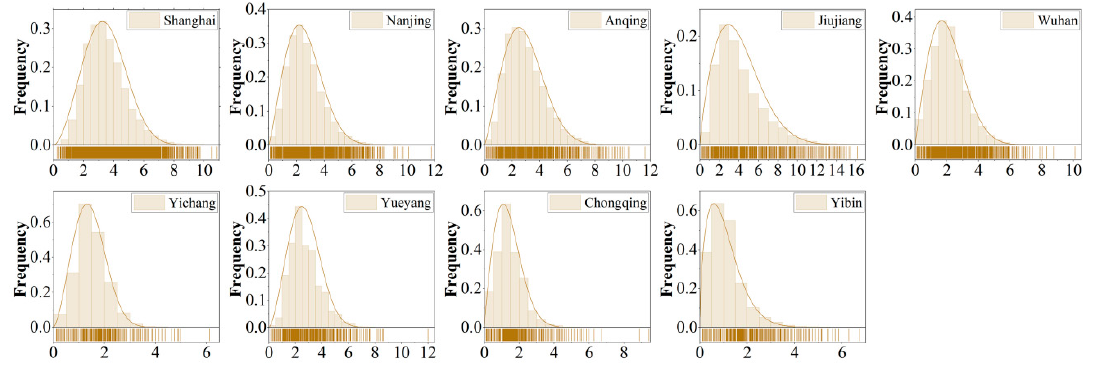
Figure 3. The frequency statistical histogram and the Weibull distribution of maximum wind speed (Unit: m·s − 1 ) for nine ports, 1979 ‒ 2020.